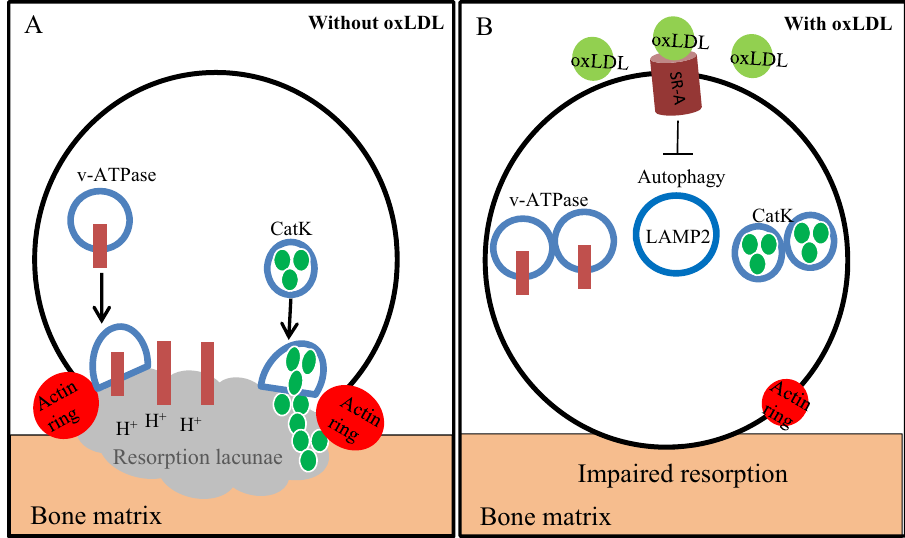
Figure 8. Regulation of CatK secretion by oxLDL. ( A ) The process of osteoclastogenesis without oxLDL. LAMP2 residing vesicles (v-ATPase and CatK) fuse readily to the ruffled border leading to an active protonation of the resorption lacunae and CatK secretion. Cytoskeletal rearrangement leads to actin rings which actively seals the resorption site from the environment. ( B ) The process of osteoclastogenesis when oxLDL is present. oxLDL binds to the SR-A in osteoclast precursor cells inhibiting the process of autophagy. This leads to an accumulation of LAMP2 residing vesicles (v-ATPase and CatK) in the cell and hence, an impaired bone resorption. Also the cytoskeletal rearrangement is impaired leading to actin rings that cannot shield the resorption site from the